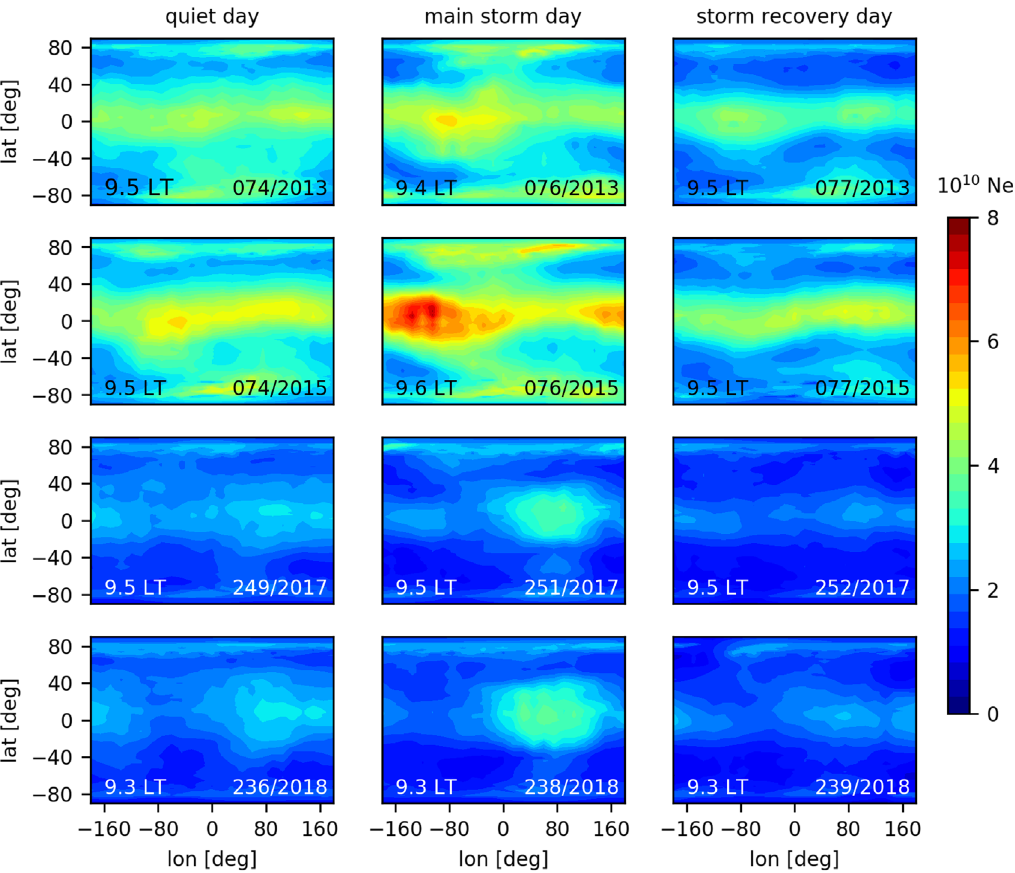
Fig. 5. Electron density distributions at height 800 km for analyzed storms obtained by tomographic reconstruction using METOP during satellite rising. The unit of the color bar is el/m 3 and the given LT hour is computed in the equatorial